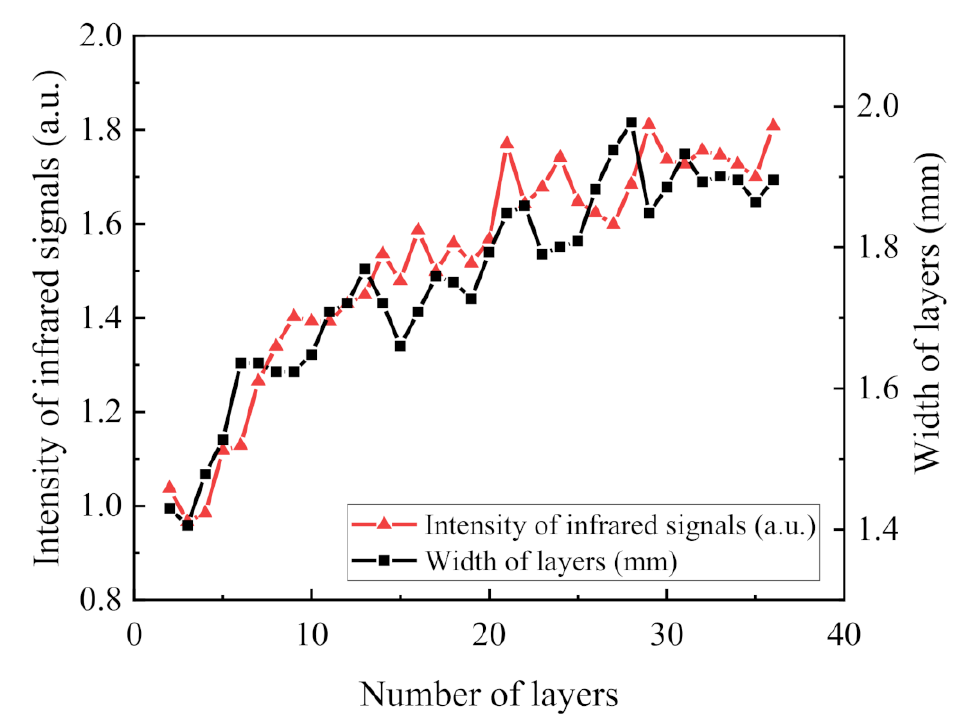
Figure 14. Relation between mean intensity of infrared light and deposition width.